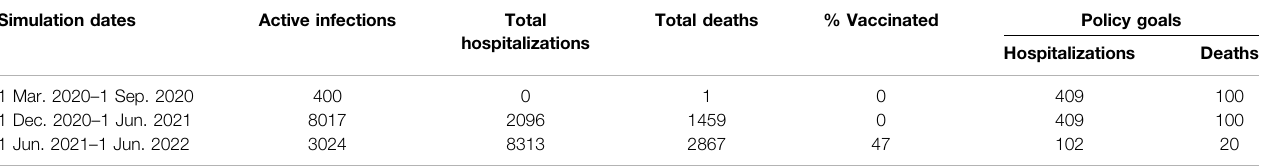
TABLE 3 | Initial conditions and policy goals used in the COVID-19 simulations in the Seattle metropolitan area. Simulation